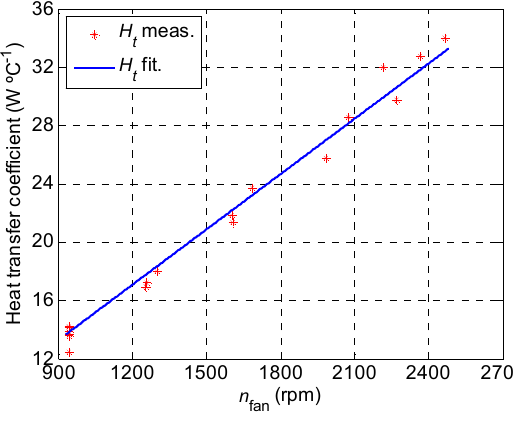
Figure 11. Experimental heat transfer coefficient ( H speed range from 900 to 2700 rpm.